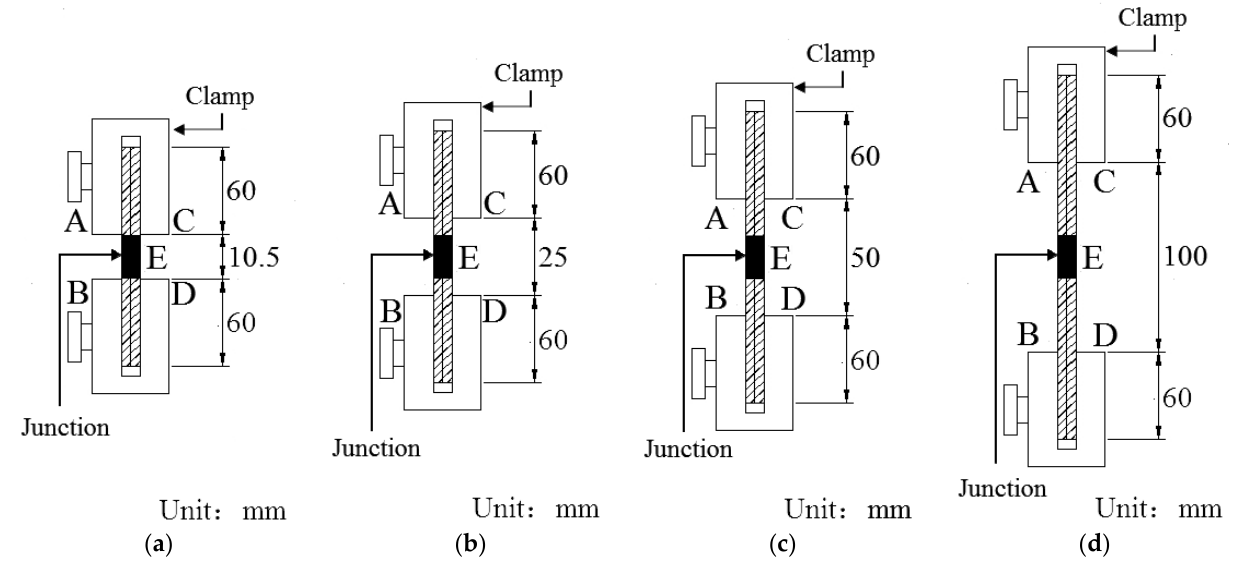
Figure 5. Weld tensile strength tests under different clamping distances: ( a ) 10.5 mm, ( b ) 25 mm, ( c ) 50 mm, ( d ) 100 mm.